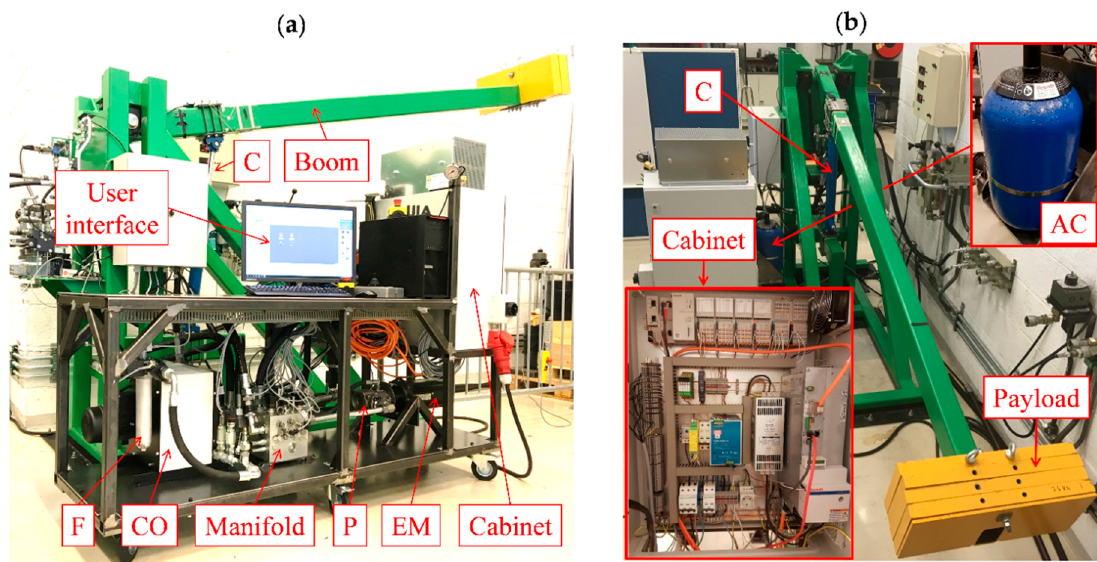
Figure 5. ( a ) Overview of the experimental test-bed; and ( b ) detailed view of the single-boom crane and of the electric cabinet dedicated to the